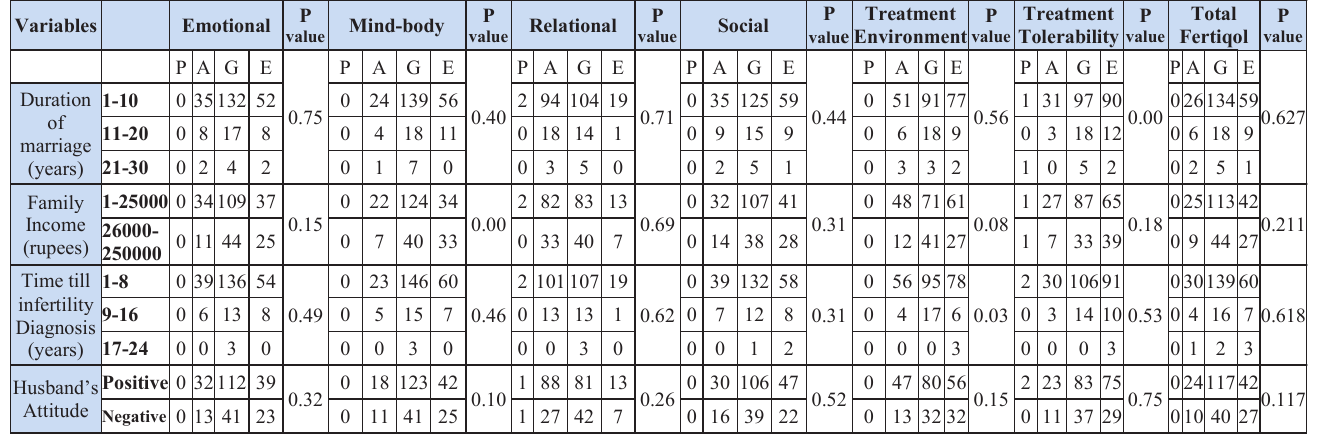
Table-5: Association of socio-demographic variables with sub-scales & total FertiQoL score